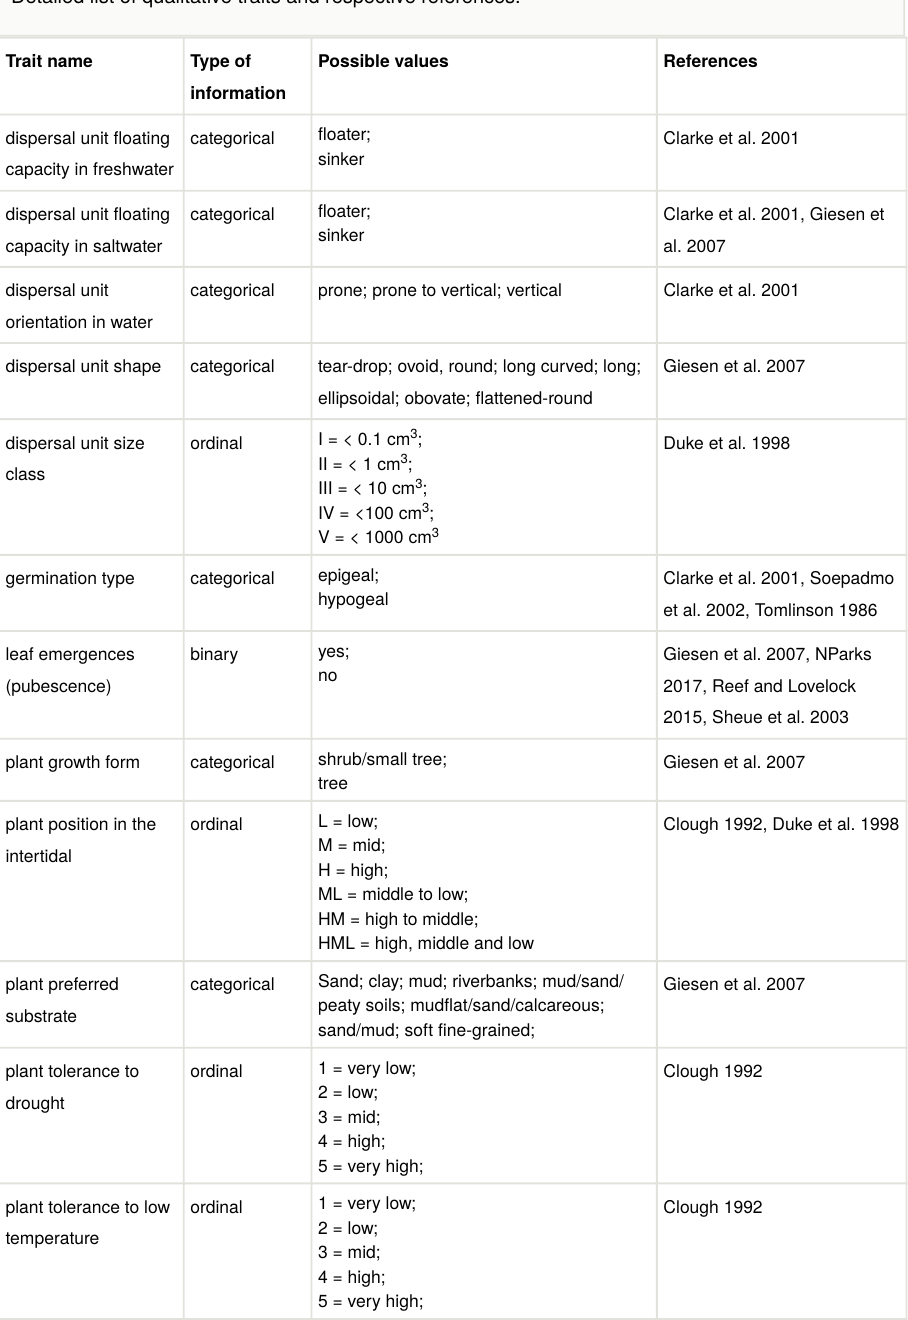
Detailed list of qualitative traits and respective